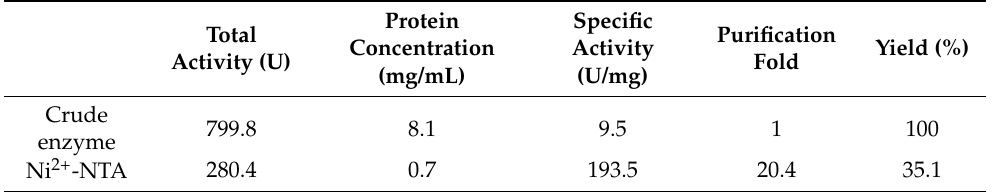
Table 1. Purification of recombinant EsFBA.